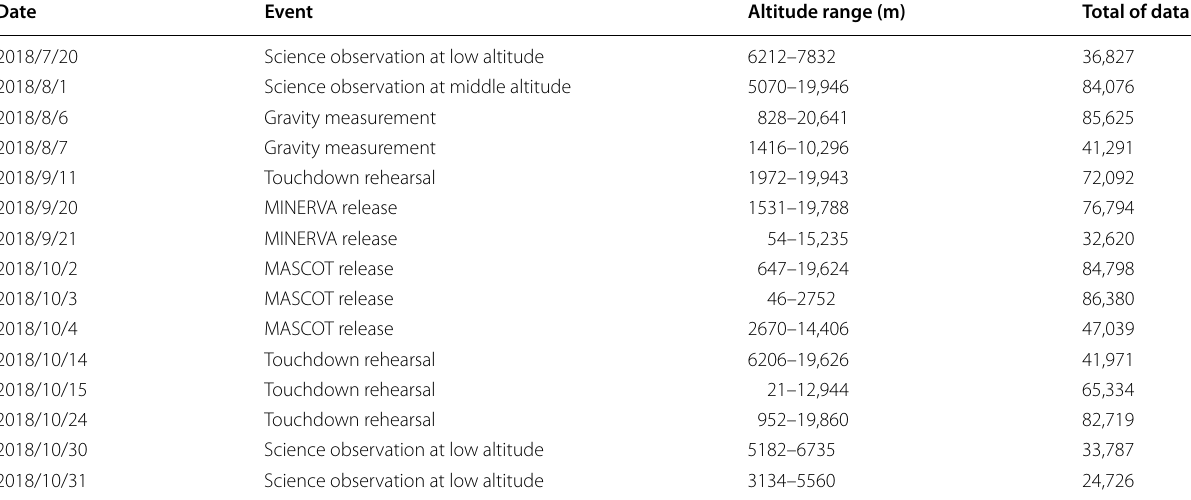
Table 3 Observation conditions in the selected 15 days